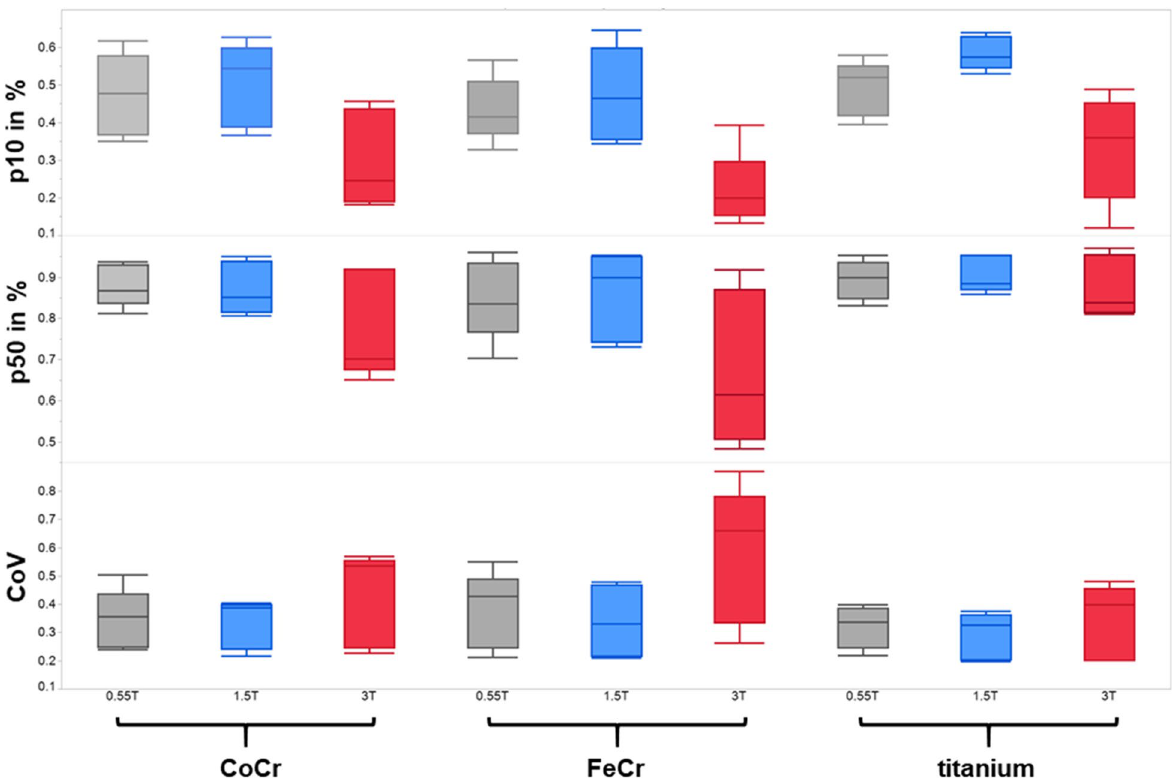
Fig. 6 Overview of the quantitative parameters p10, p50, and coefficients of variation (CoV) for the different field strengths and alloys. See text (in the “Methods” section) for explanation of p10, p25, and